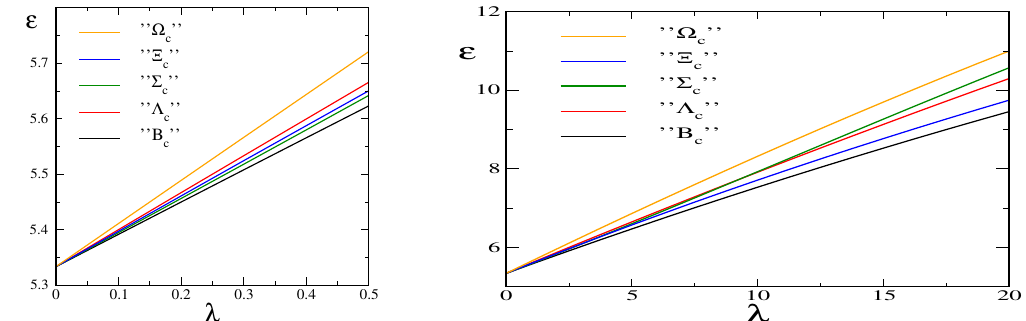
Figure 6. (Color online) Flavor symmetry breaking eigenvalues for states that at λ = 0 are pure 15 states, cf. Figure 5. The parameter λ measures the strength of symmetry